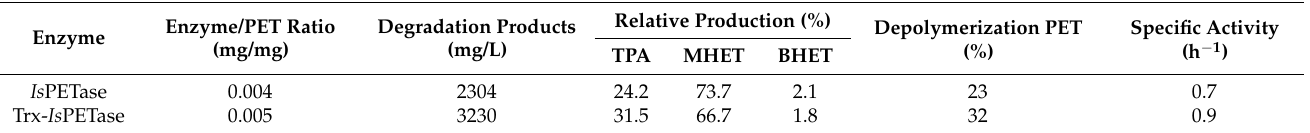
Table 2. PET depolymerization activity of Is PETase and Trx- Is PETase. Degradation products consist of the sum of the TPA, MHET, and BHET